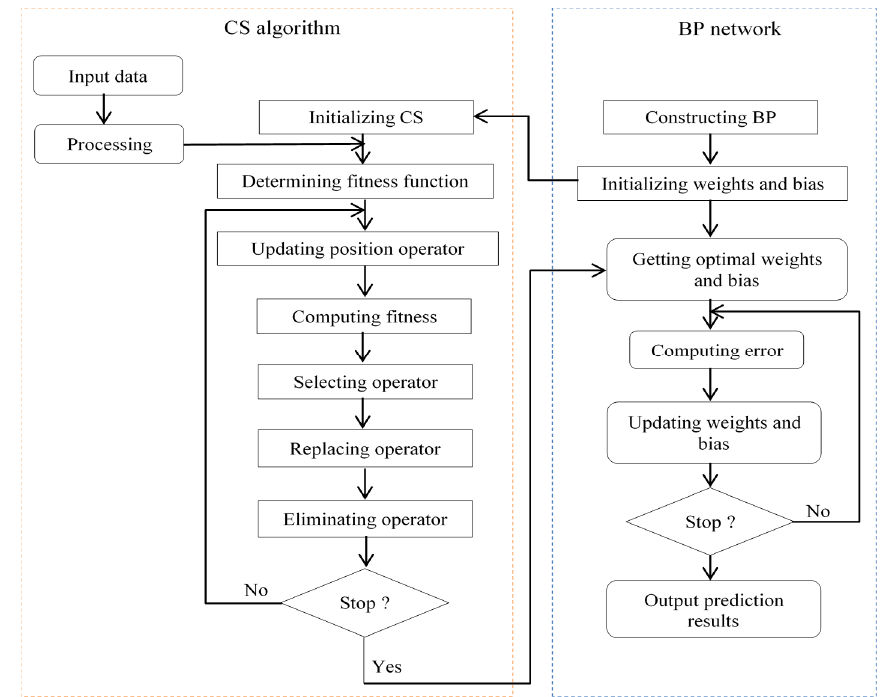
Figure 10. Flowchart of CSNN combination [21].